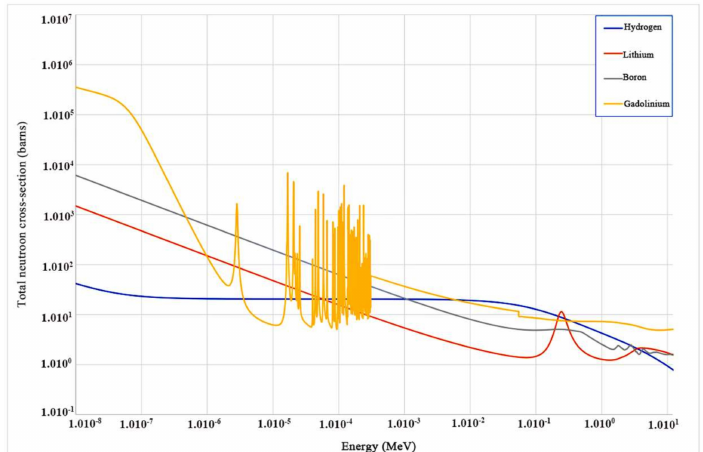
Figure 10. Neutron capture cross sections of hydrogen, lithium, boron, and gadolinium isotopes. Hydrogen isotope: blue line; lithium isotope: red line; boron isotope: grey line; gadolinium isotope: yellow line. Reproduced with permission [50]. Copyright 2019,